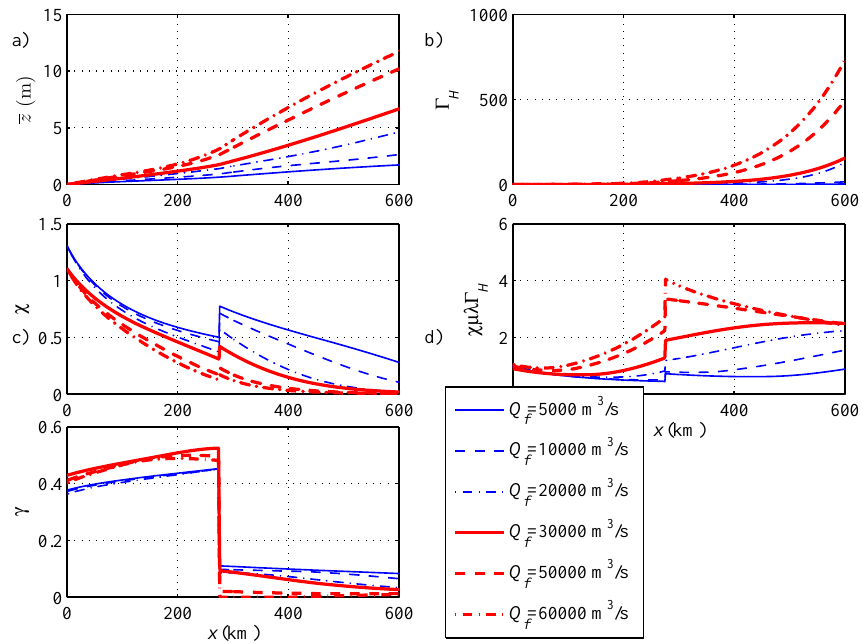
Figure 9. Longitudinal variation of the residual water level z (a) , the parameter 0 H (b) , the friction number χ (c) , the friction term χ µλ0 H in Eq. (T4), and the shape number γ (e) in the Yangtze estuary under different river discharge